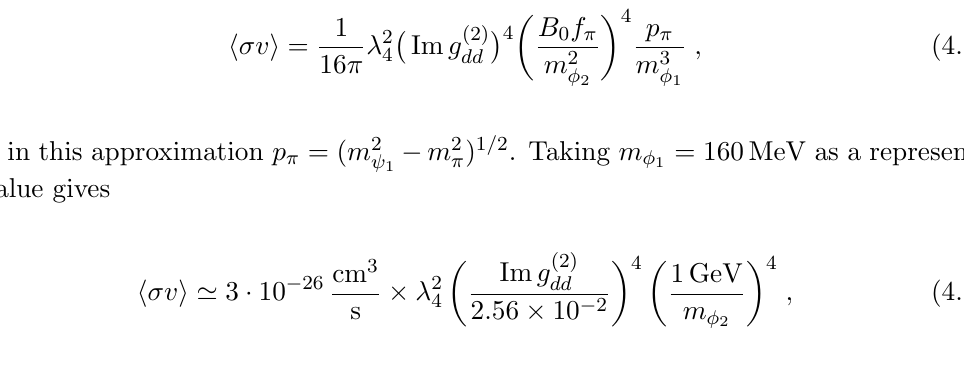
Figure 17 . Graph dominating the annihilation cross section of (cid:30) 1 (cid:30) 1 in Model 2 and Model 3